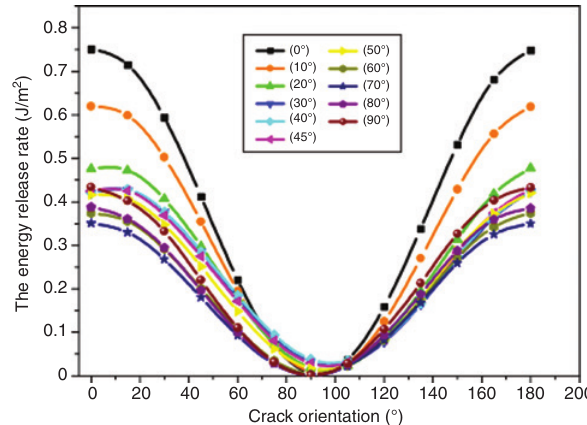
Figure 11: Variation of the energy release rate in function of the orientation of the cracks for all orientations of the fibers where the two circular notches are inclined at an angle of 45 ° .